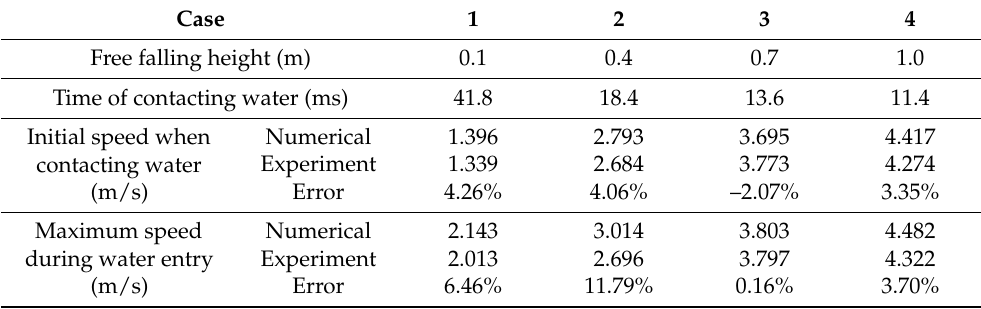
Table 10. Comparison of speed information at different free falling